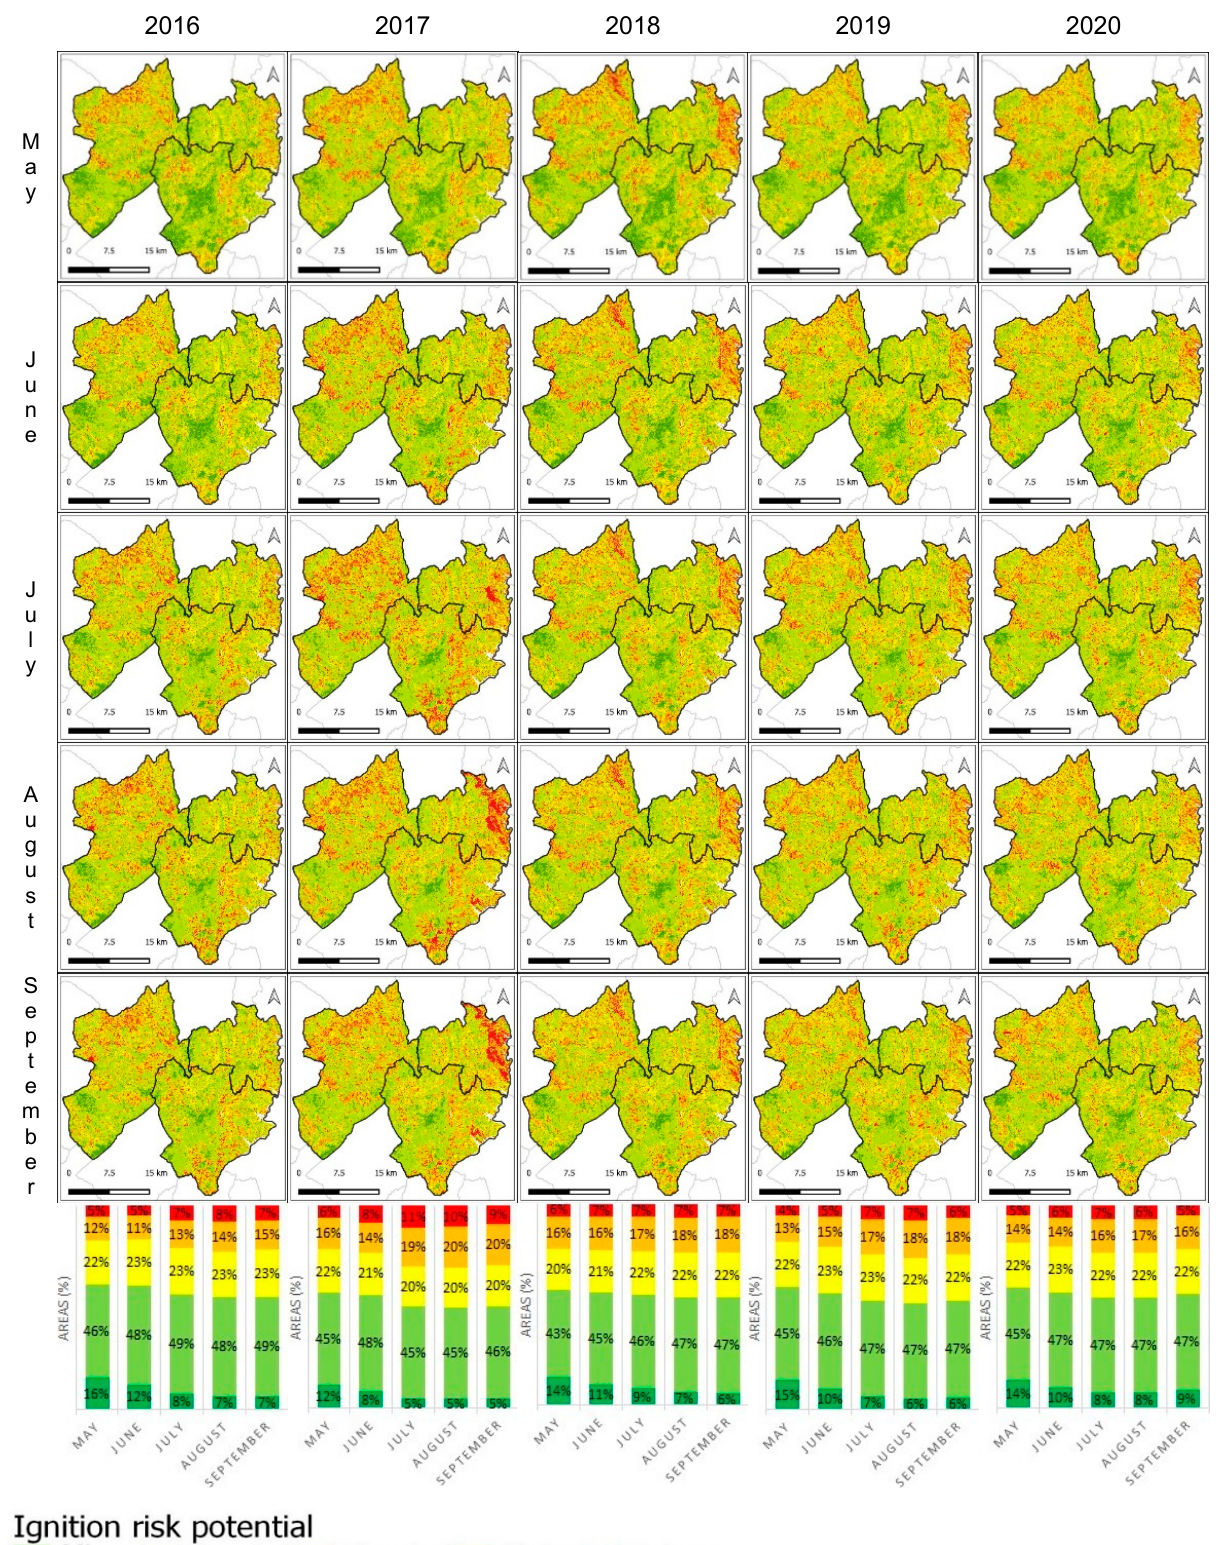
Figure 3. Ignition potential risk maps from the four critical fire risk months for the 2016–2020 period, followed by an analytic percentage graph of yearly representative areas of 5 risk classes.